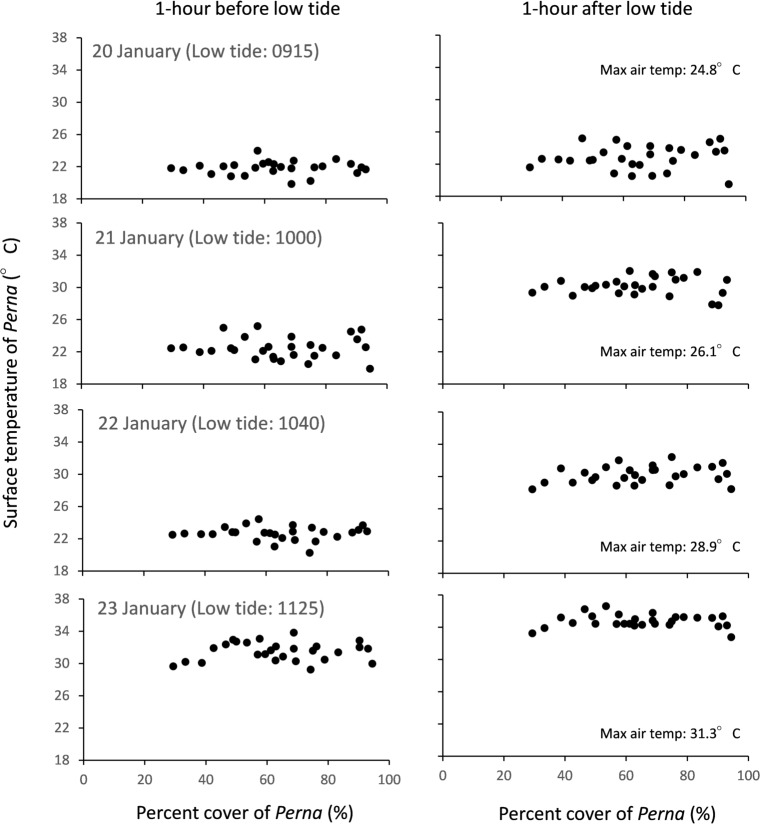
Relationship between percent cover of P. perna and the mean surface temperatures of P. perna within naturally occuring midshore mussel beds during four consecutive day-time summer low-tides.Left column represents measurements taken approximately one hour before low-tide; right column represents measurements taken approximately one hour after low tide.